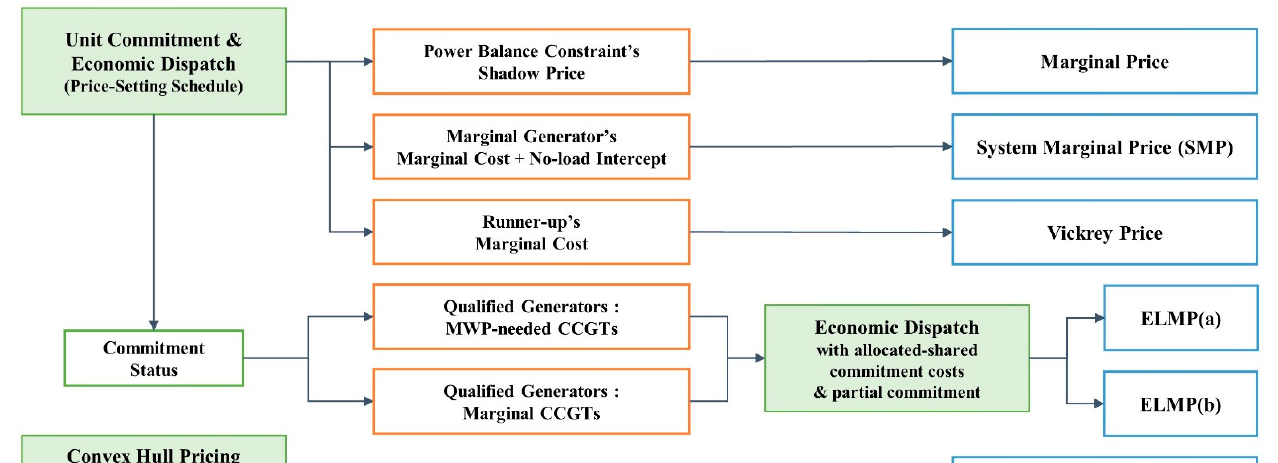
Figure 3. Overview of the simulation process for the market price mechanisms. 3.2.2. Financial Analysis After calculating the market prices under each pricing mechanism, the settlement amount of each generator should be calculated to compare and analyze the financial im- pact on generators. The settlement amount is calculated as the product of the generation amount of each generator and the market price, which can be calculated using the results of separate UCED processes and the pricing methods described in the previous subsection and which can be described as follows: (cid:1842)(cid:1867)(cid:1875)(cid:1857)(cid:1870)(cid:1842)(cid:1873)(cid:1870)(cid:1855)ℎ(cid:1853)(cid:1871)(cid:1857)(cid:1829)(cid:1867)(cid:1871)(cid:1872) = (cid:3533) (cid:3533) (cid:2024) (cid:3047) (cid:1868) (cid:3034),(cid:3047)∗ (cid:3034)∈(cid:3008) (cid:3251)